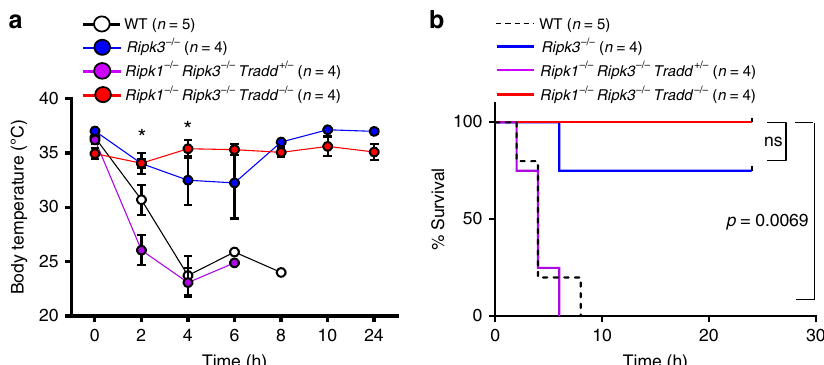
Fig. 5 Ripk1 − / − Ripk3 − / − Tradd + / − mice succumb to lethal TNF α -induced shock. a Body temperatures of mice of indicated genotypes over time. t tests show a signi fi cant difference in body temperature between Ripk1 − / − Ripk3 − / − Tradd + / − and Ripk1 − / − Ripk3 − / − Tradd − / − mice at 2 h and 4 h after injection. Graph presented as mean ± SEM. * p < 0.05 as determined by Student ’ s t test. b Kaplan – Meier plot showing survival of mice of indicated genotypes. Logrank test shows a signi fi cant difference in survival between Ripk1 − / − Ripk3 − / − Tradd + / − and Ripk1 − / − Ripk3 − / − Tradd − / − mice ( p